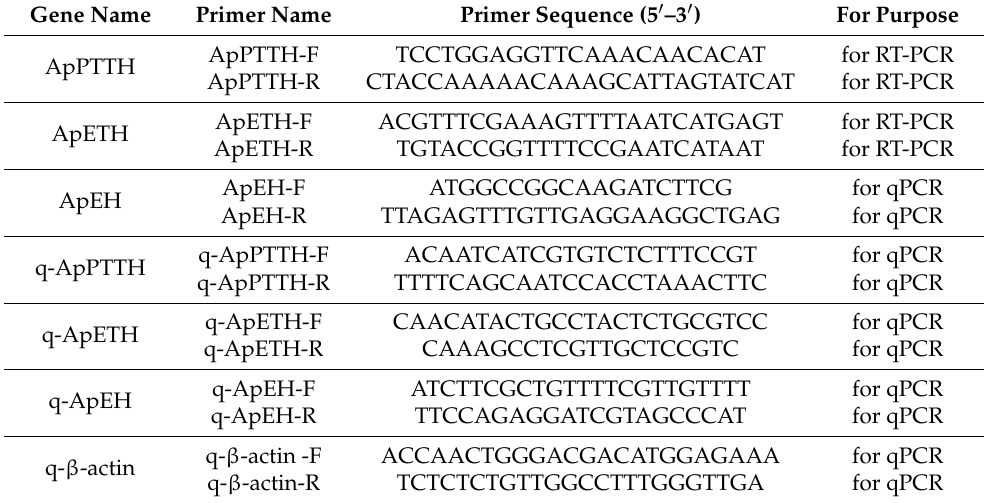
Table 1. Oligonucleotide primers for this